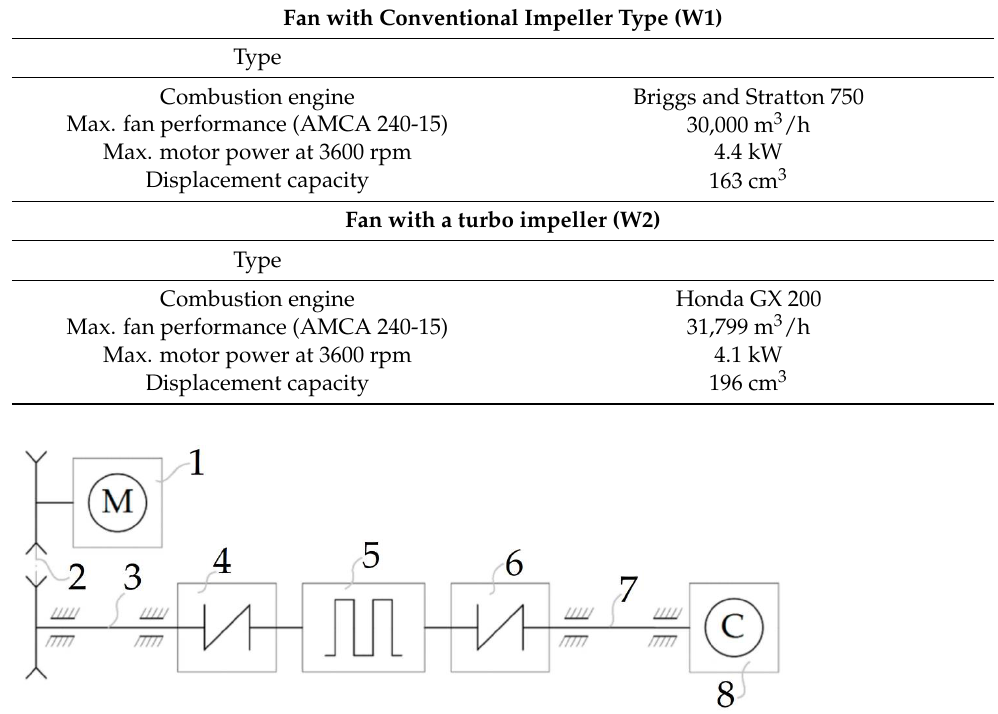
Figure 2. Schematic of the test station: 1, tested engine; 2, belt transmission (ratio 1:1); 3 and 7, inter-